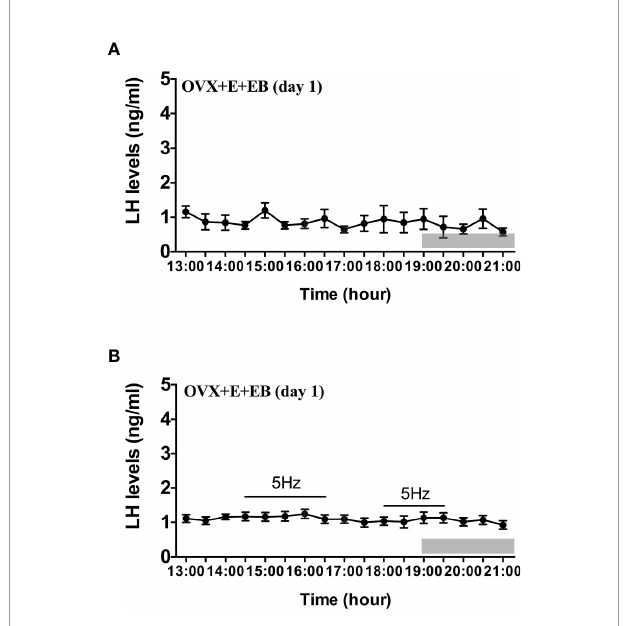
FIGURE 5 | Effects of optogenetic activation of ARC kisspeptin neurons on LH secretion in OVX estradiol capsule implanted Kiss-cre mice injected with estradiol benzoate. (A) Mean circulating levels of LH without optic stimulations of ARC kisspeptin neurons in OVX Kiss-cre mice implantation of estradiol capsule (E) and injection of estradiol benzoate (EB) and blood samples collected on the day of EB injection (OVX+E+EB, day1) (n = 4). (B) Mean circulating levels of LH secretion in response to 5 Hz blue-light stimulations of ARC kisspeptin neuron (14:30 - 16:30 h and 18:00 - 19:30 h) in Kiss-cre OVX+E+EB mice (n = 5). The values are presented as mean ± SEM. Lights off is at 19:00 h for all experiments, as indicated by the grey bar on the